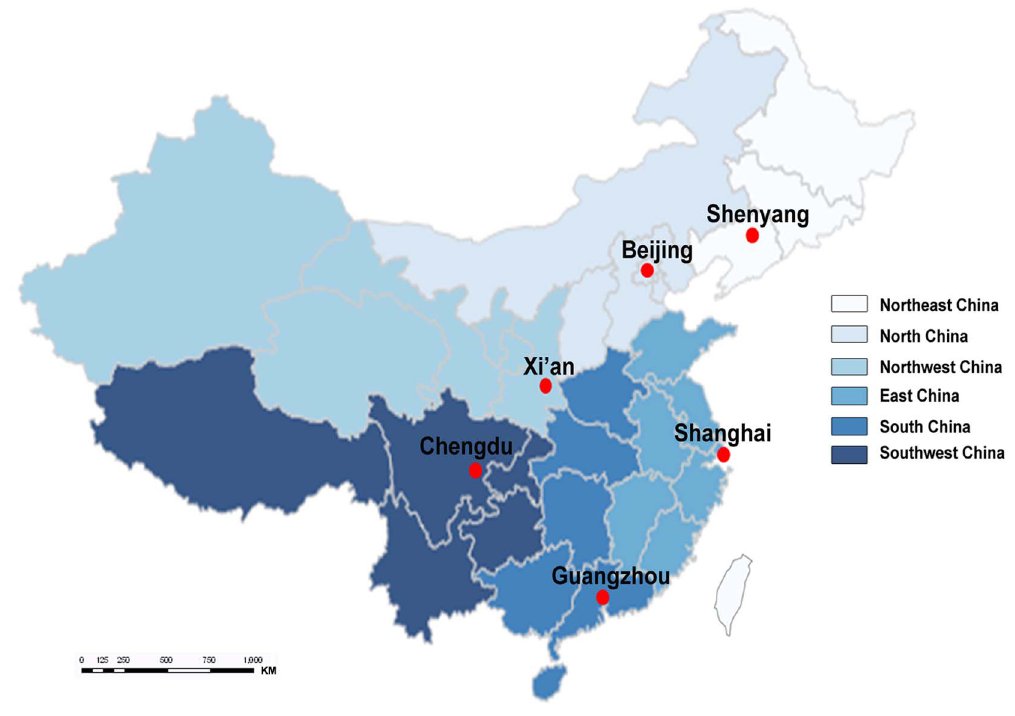
Figure 1. Map of six clinical research centers in this study.